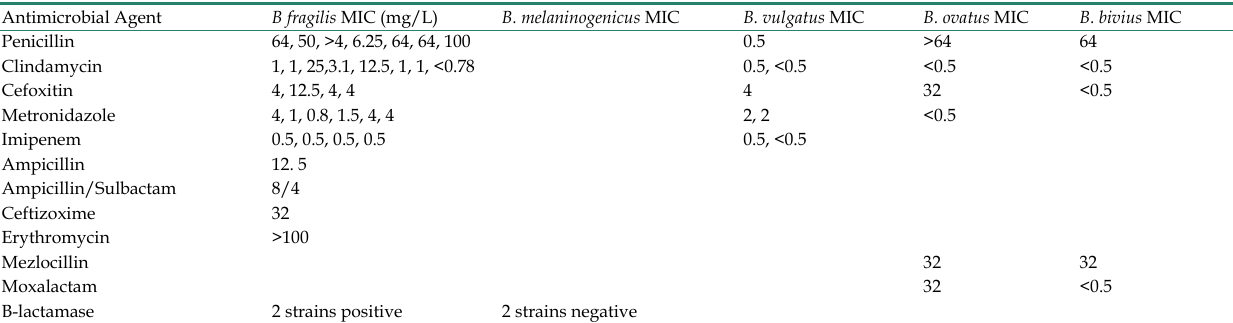
Table 2. Various Bacteroides species isolates and susceptibility data based on antibiotics tested Antimicrobial